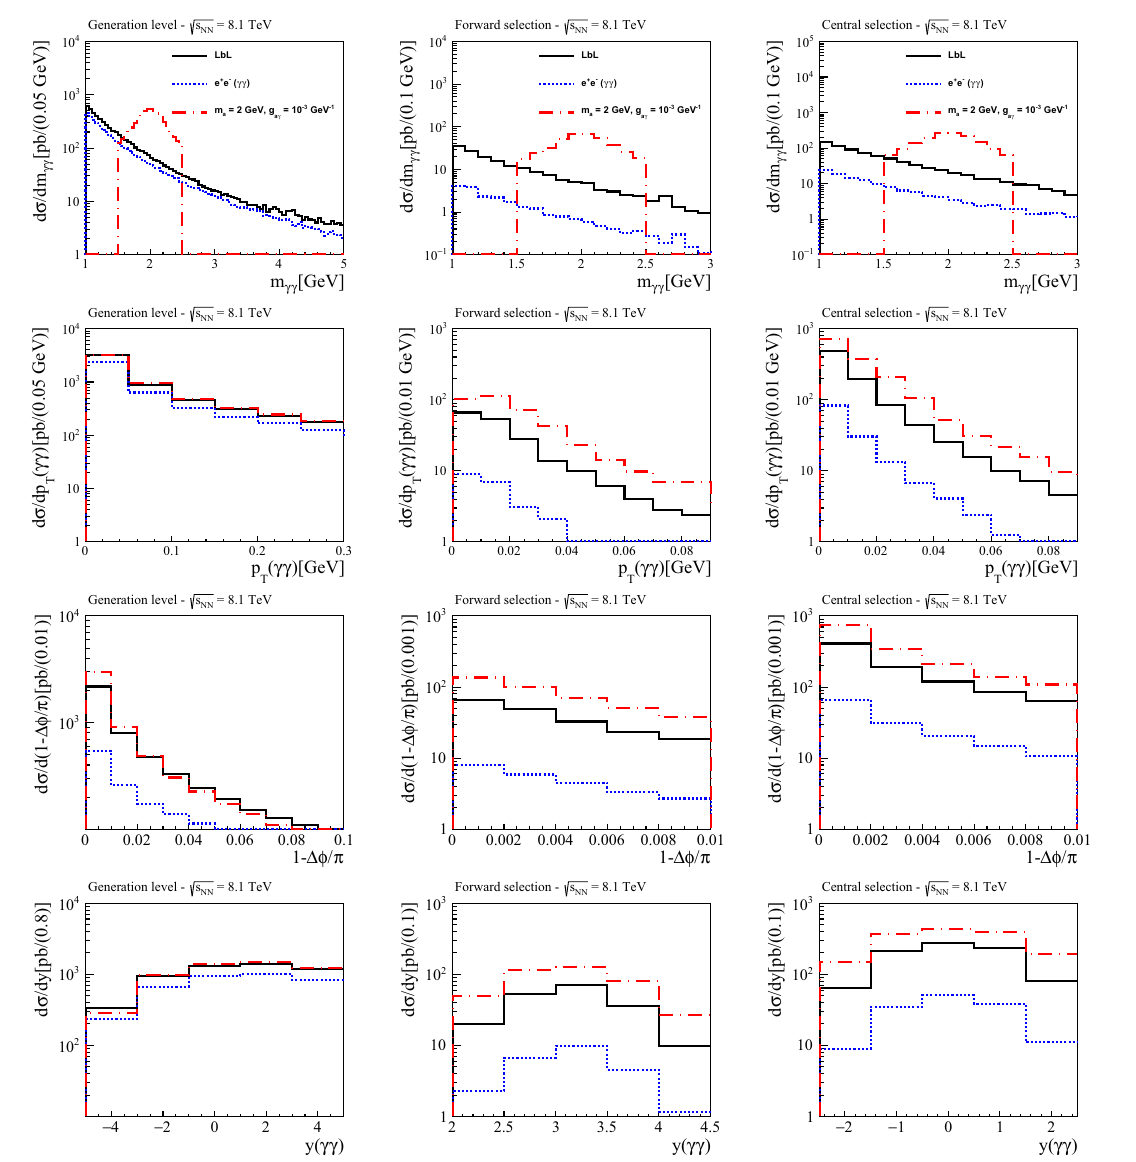
tion level (left panels) and considering the forward (middle panels) and Fig. 2 Predictions for the invariant mass m γγ , transverse momentum p T (γγ) , acoplanarity and rapidity distributions of the diphoton system central (right panels) √ s nn = 8 . 1 TeV derived at genera- produced in Pb – p collisions at